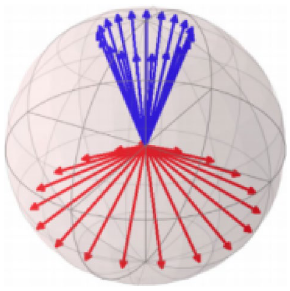
Figure 3. Representation of the state set (child